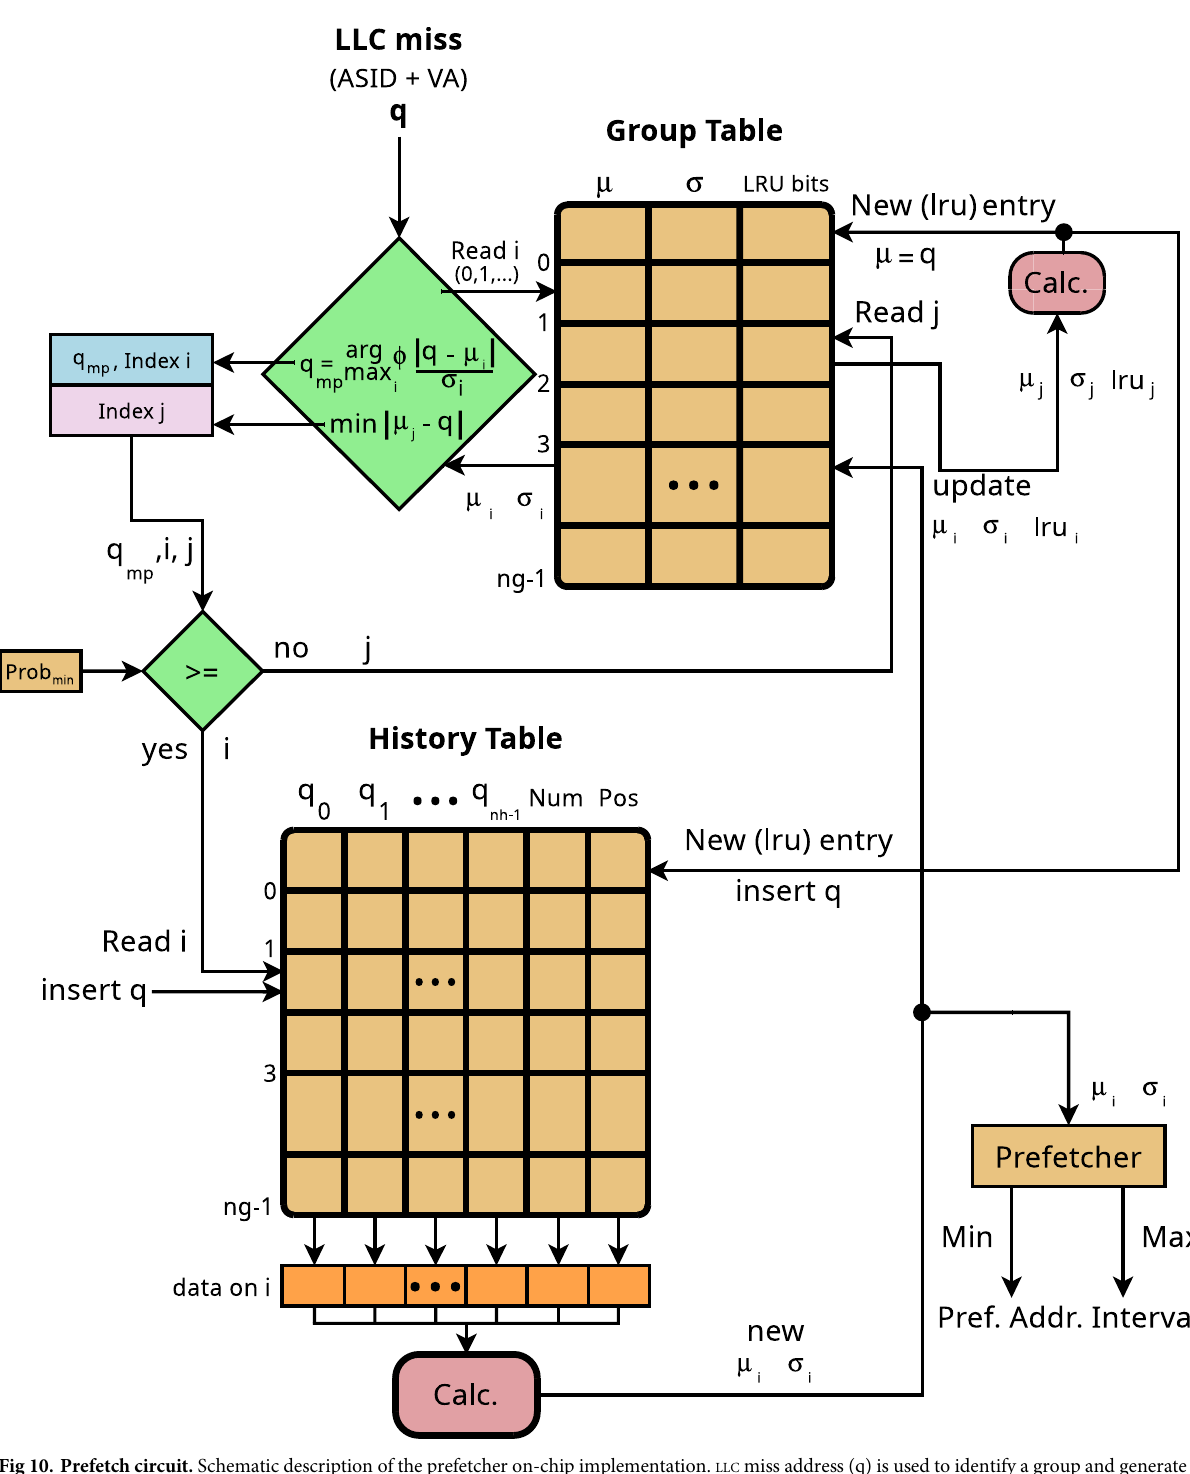
Fig 10. Prefetch circuit. Schematic description of the prefetcher on-chip implementation. LLC miss address (q) is used to identify a group and generate the prefetch address interval, or to create a new group based on the nearest current group. This implementation of HMM allows for precise identification of the simultanenous off-chip memory groups accessed by the different processes running in a multicore chip.